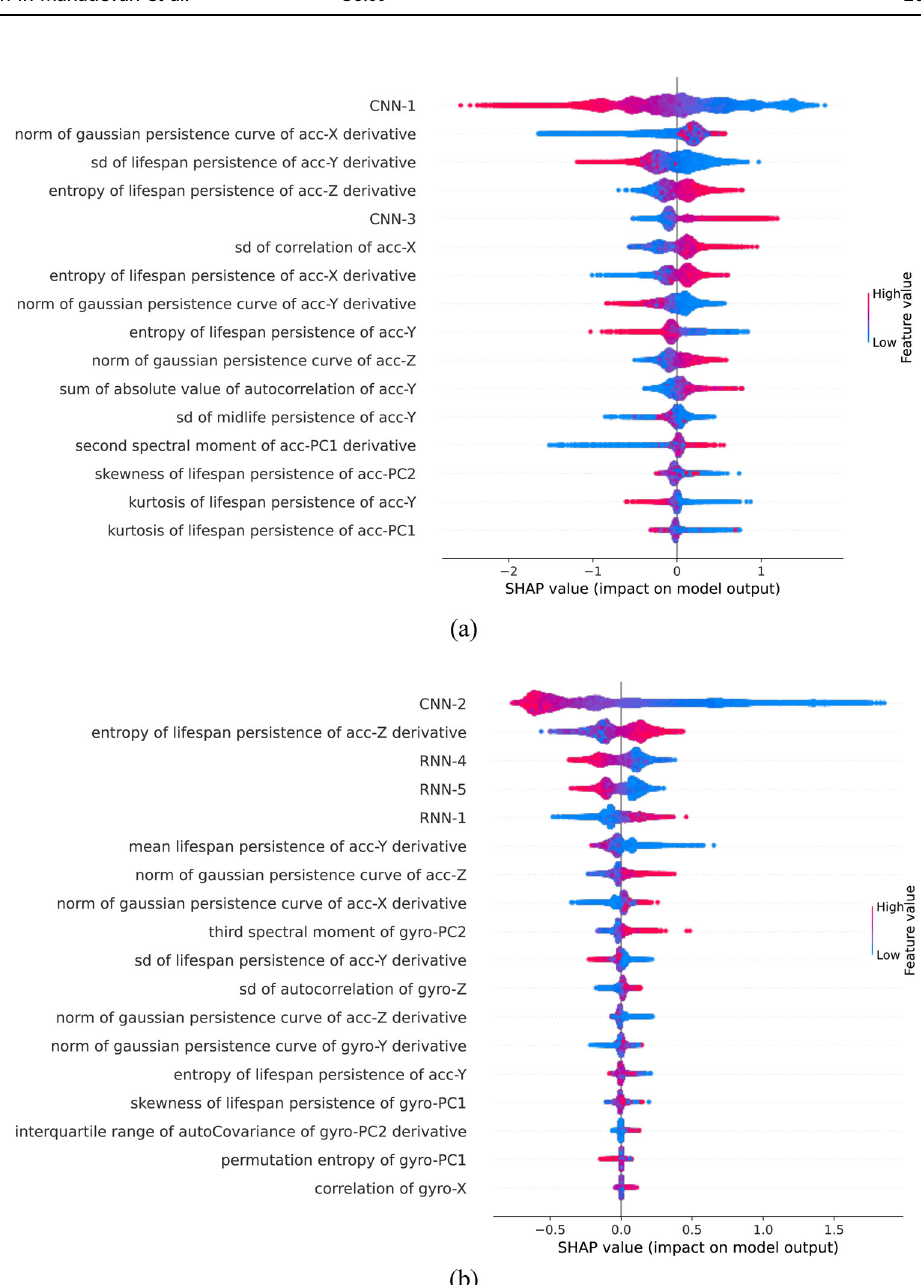
Fig. 2 Feature importance. a The model with accelerometer data with 16 selected features. b The model with both accelerometer and gyroscope data with 18 selected